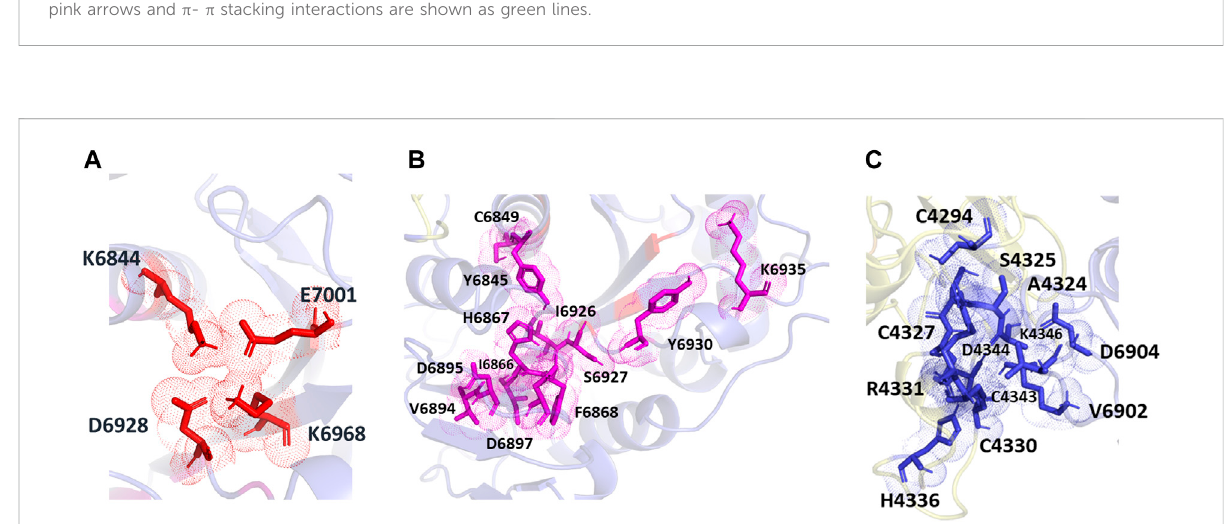
FIGURE 6 The different POOL predicted sites for the SARS-CoV-2 RNA methyltransferase (NSP16/NSP10 complex) (A) The POOL-predicted residues in site1,whichcontainstheD-K-EpartoftheK-D-K-Econservedcatalyticmotif(D6928,K6968,andE7001)withanadditionalK6844,areshowninred (B) POOL-predicted site 2, containing residues surrounding the catalytic motif, is shown in magenta. (C) Site 3, and the POOL-predicted residues at the dimer interface, in